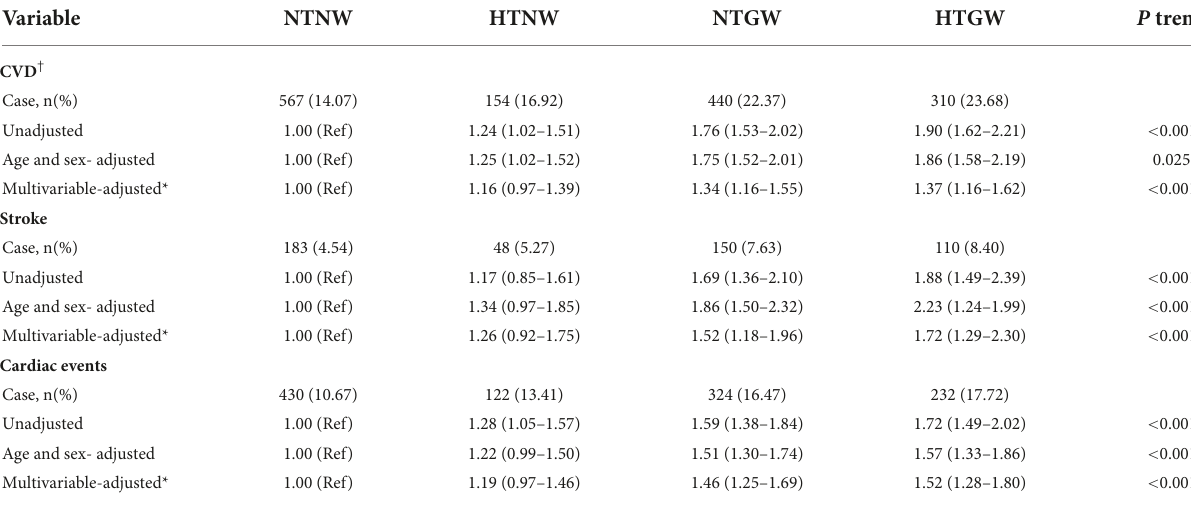
TABLE 2 Risk of cardiovascular disease (CVD), stroke and cardiac events by high triglyceride levels and enlarged waist circumference (HTGW) phenotype. Variable